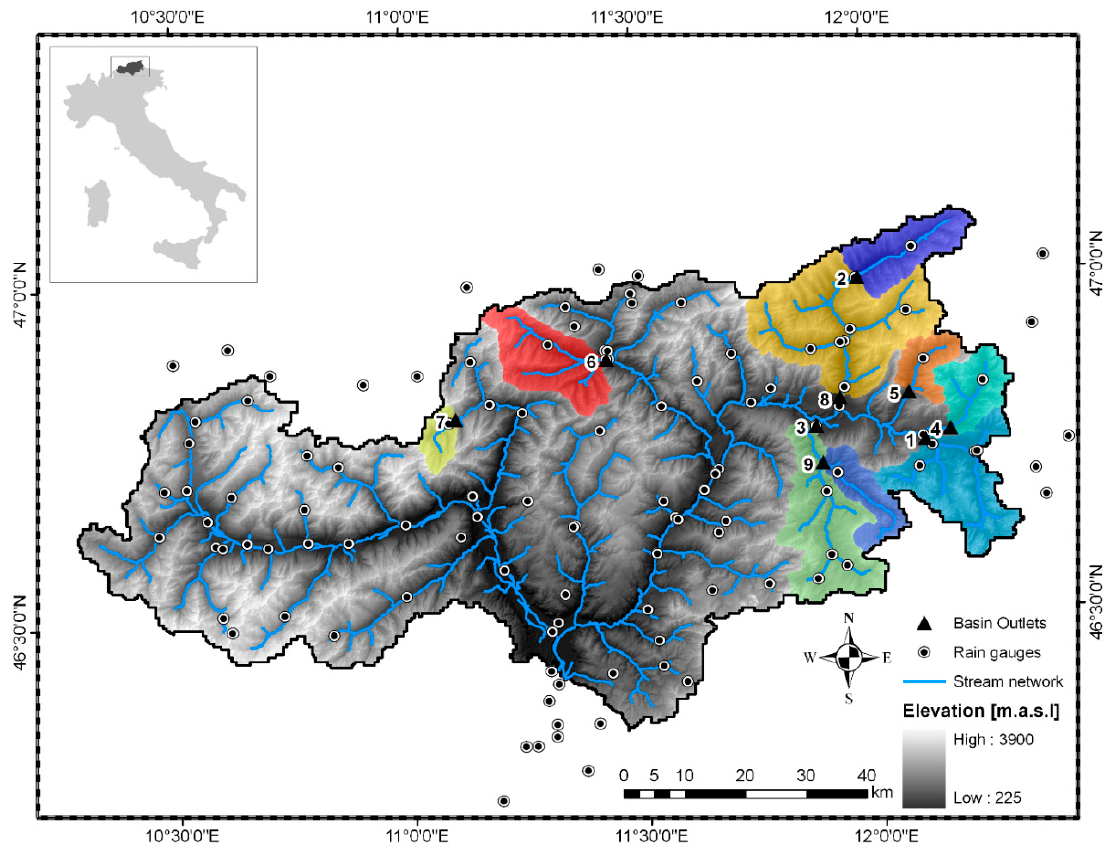
Figure 1. Location and topography of the sub-basins.